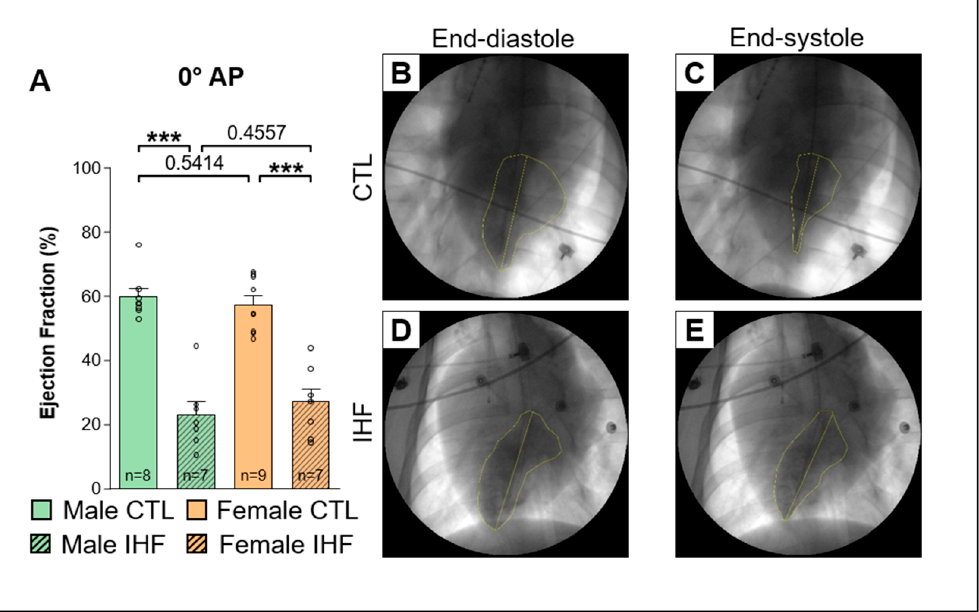
Figure 1. Ejection fraction (EF) assessed by laevocardiography at 130 bpm at 0 ◦ AP (anterior posterior). ( A ), Ejection Fraction. ( B , C ), Representative images of a control pig at end-diastole ( B ) and end-systole ( C ). ( D , E ) Representative images of an IHF pig at end-diastole ( D ) and end-systole ( E ). CTL , control animals without ischemic heart failure; IHF , animals with ischemic heart failure. Bar graphs represent Mean + SEM, grey circles represent data of individual pigs. Mann-Whitney-U Test. *** p < 0.001.